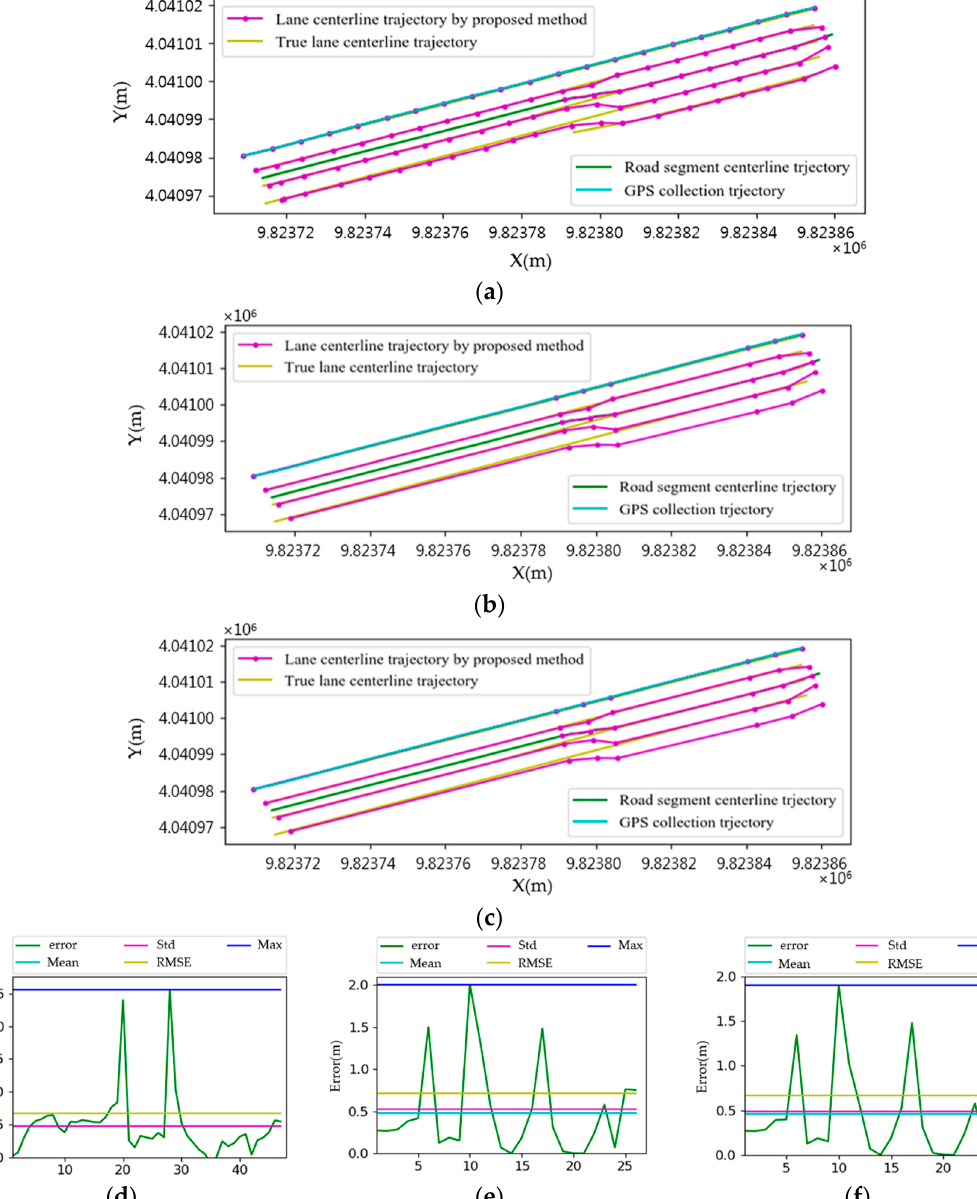
Figure 11. Errors between the true road segment lane trajectories and lane trajectories generated by ( a , d ) unimproved; ( b , e ) grid-based; and ( c , f ) the proposed algorithms.